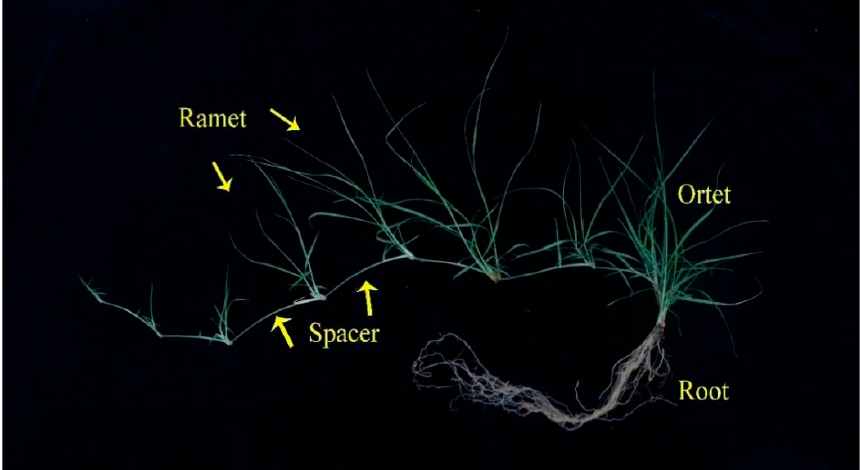
Figure 4. Schematic diagram of Buchloe dactyloide.